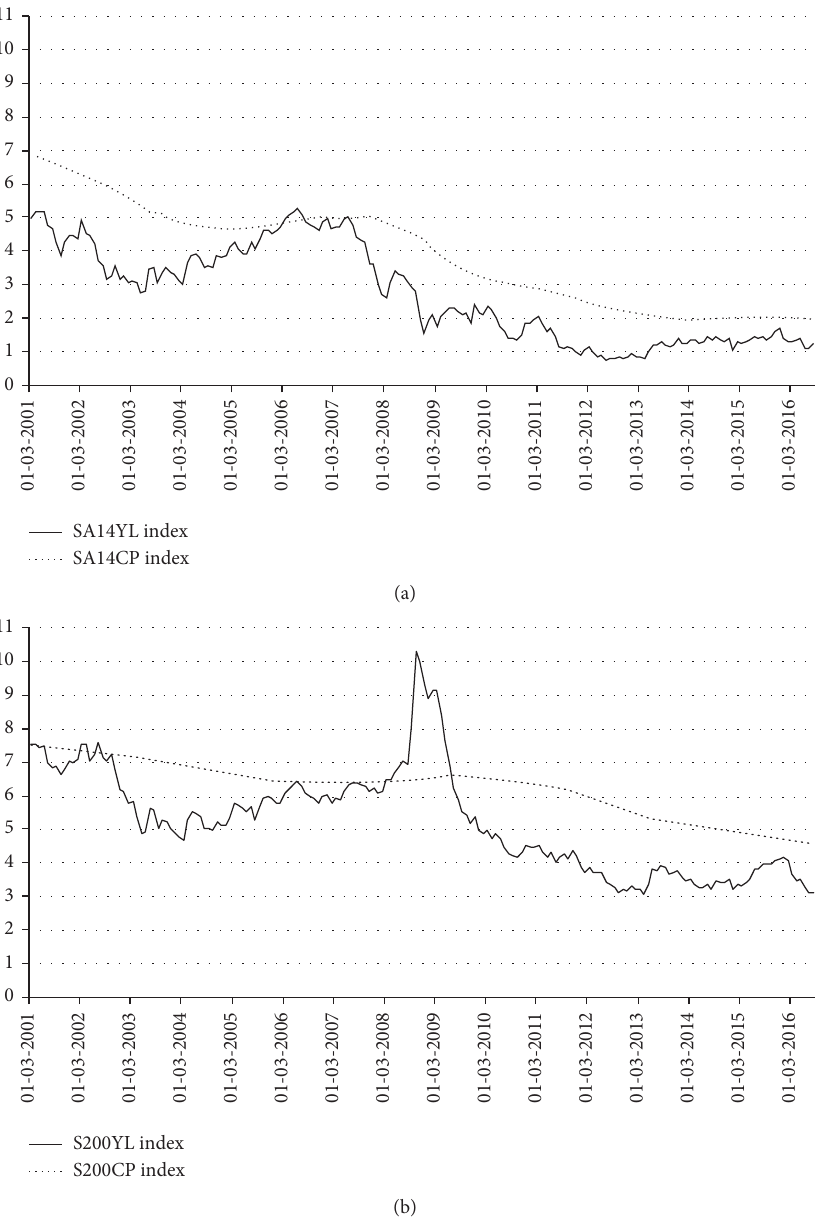
Figure 1: Yields and average coupons for the US BBB-rated (a) and UST bonds (b),